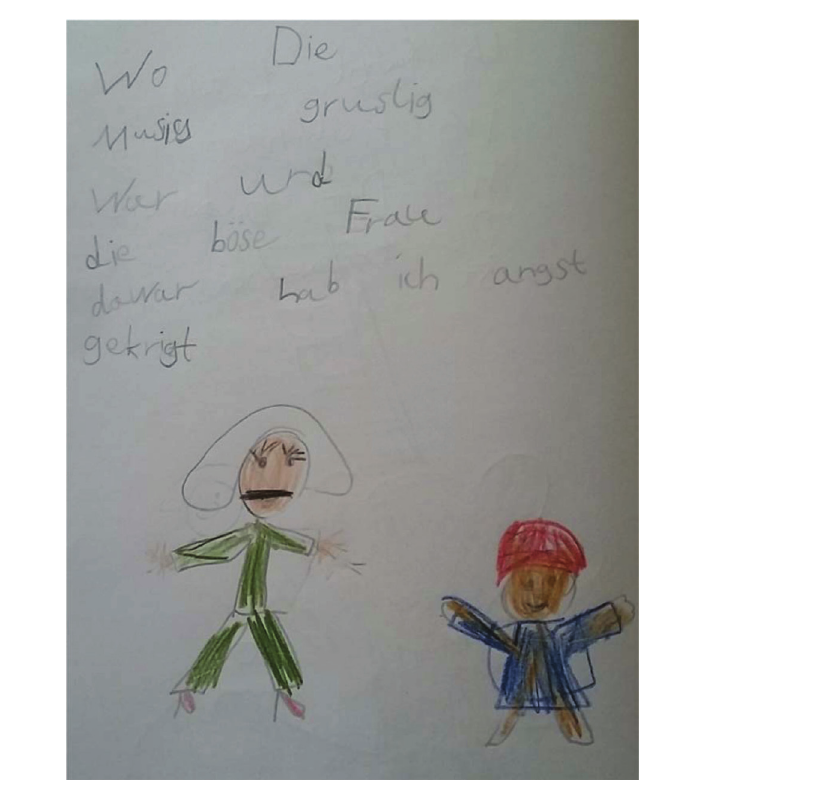
Figure 8: Primary school child’s commentary on the Paddington screening: ‘When the music was spooky and the mean woman showed up, I got